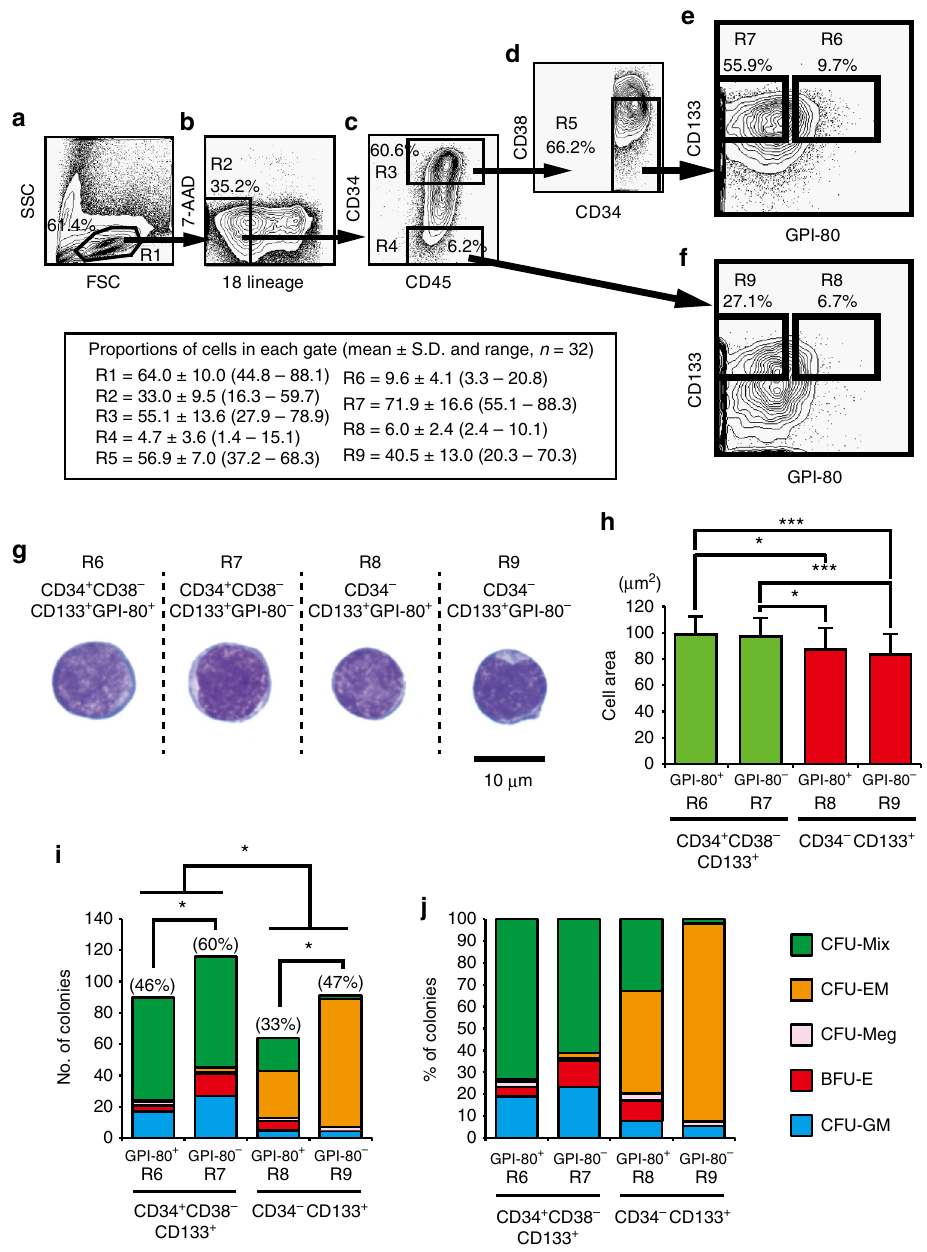
Fig. 1 Representative FACS pro fi le and colony-forming capacity of highly puri fi ed CB-derived 18Lin - CD34 + CD38 - CD133 + GPI-80 + / − and 18Lin - CD34 − CD133 + GPI-80 + / − cells. A representative FACS pro fi le is shown. a The forward scatter/side scatter (FSC/SSC) pro fi le of immunomagnetically separated Lin − cells. The R1 gate was set on the blast-lymphocyte window. b The R2 gate was set on the 18Lin − living cells. c The R2 gated cells were subdivided into two fractions: 18Lin − CD45 + CD34 + (R3) and CD34 − (R4) cells, according to their expression of CD34. The de fi nitions of CD34 + / − cells are as follows: the CD34 + fraction contains cells expressing >5% of the maximum BV421 fl uorescence intensity (FI). The CD34 − level of FI was determined based on the Fluorescence Minus One controls. d The cells residing in the R3 gate were further subdivided into 18Lin − CD45 + CD34 + CD38 − (R5) cells. The CD38 − fraction contains cells expressing <10% of the maximum PE-Cy7 FI. e The R5-gated cells were further subdivided into two fractions: 18Lin − CD45 + CD34 + CD38 − CD133 + GPI-80 + (R6) and GPI-80 − (R7) cells according to their expression of CD133 and GPI-80. f The R4-gated cells were further subdivided into two fractions: 18Lin − CD45 + CD34 − CD133 + GPI-80 + (R8) and GPI-80 − (R9) cells. The de fi nitions of CD133 + / − and GPI-80 + / − cells are the same as reported 22,25 . The phenotypic purity of the R6 and R8 sorted cells consistently exceeded 99%. Detailed FCM data, including numbers of experiments, and mean ± S.D. and ranges of proportions of cells in each gate, are depicted in the fi gure. g Cells sorted from the R6 to R9 fractions were cytospun on to the slide glasses and stained with May – Grunwald – Giemsa. h The areas of the R6 to R9 cells were analyzed using the Image J software program (mean ± S.D., n = 33 cells/group, * p < 0.05, *** p < 0.001, Tukey ’ s multiple comparison procedure). i Single-cell CFCs of sorted R6 to R9 cells. The plating ef fi ciency (PE) is shown in parentheses (mean ± S.D., 196 cells/group, * p < 0.05, two-way analysis of variance). j The percentages of various types of colonies are shown. CFU-Mix (green bar), CFU-EM (orange bar), CFU-Meg (pink bar), BFU-E (red bar) and CFU-GM (blue